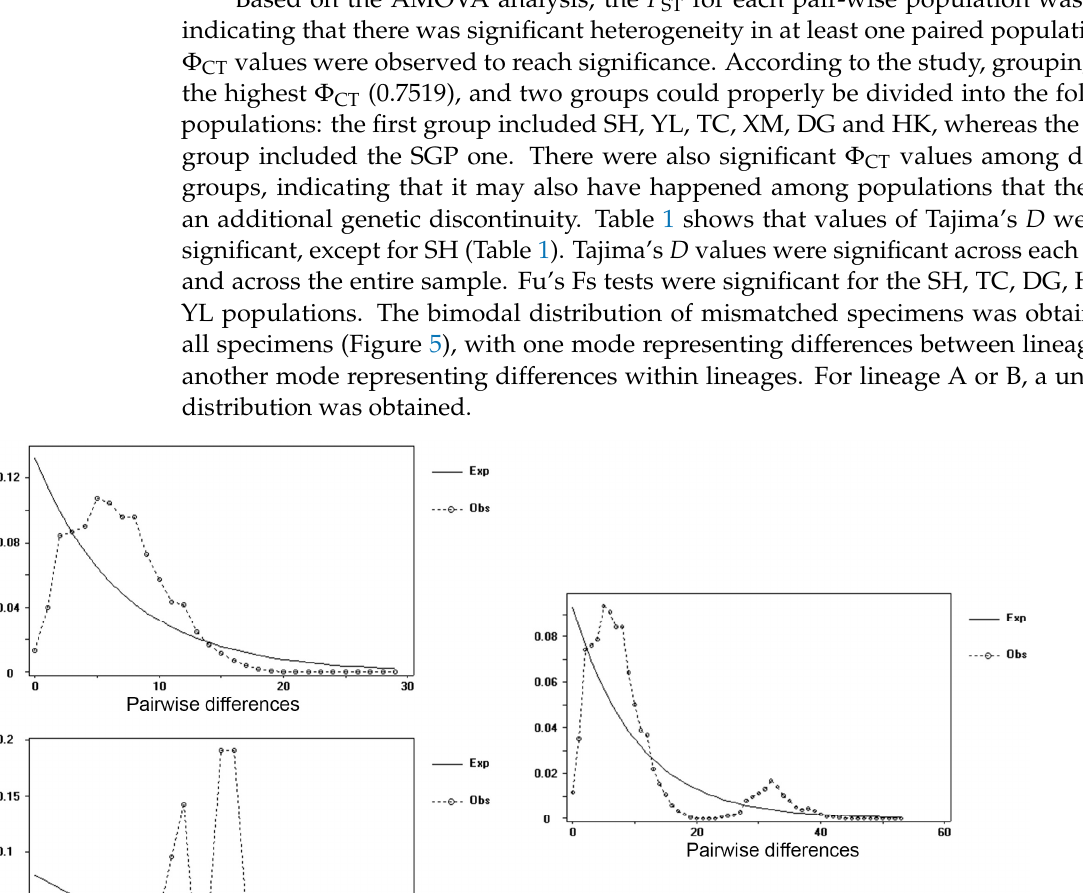
Source of Percentage of Φ -Statistics p (More-Extreme Variation Variation Value)